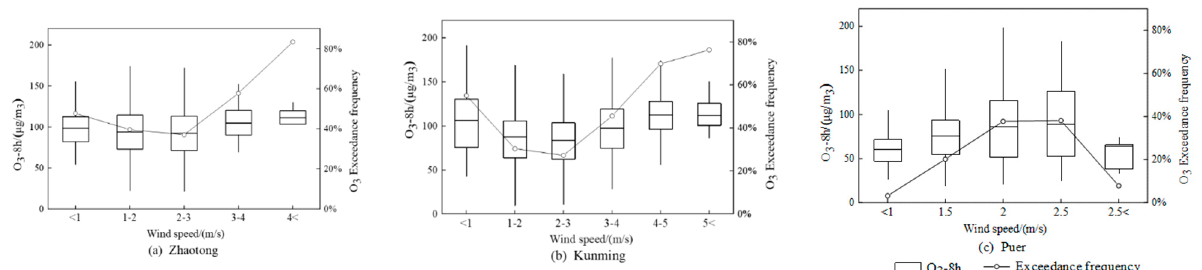
Figure 11. Different changes from wind speed and O 3 concentration between Zhaotong, Kunming and Pu’er.